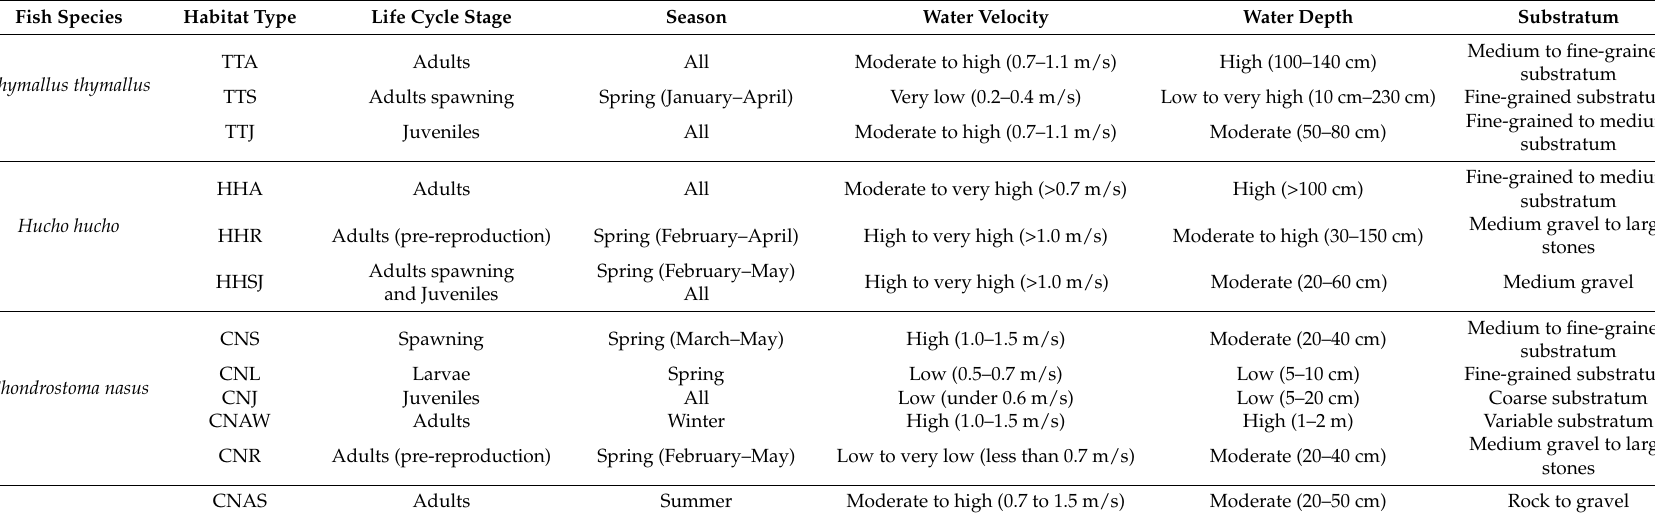
Table 1. List of habitats associated with life-cycle stages of Thymallus thymallus L., Hucho hucho L., and Chondrostoma nasus L. described in terms of their physical